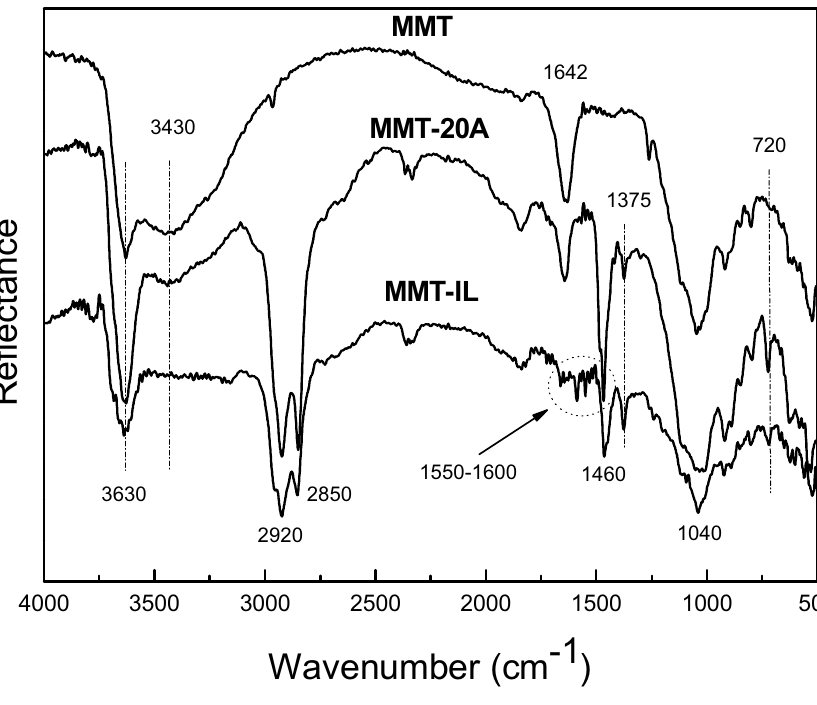
Fig. 4 Thermogravimetric curves and the first deriva- tive curves for the MMT-20A, MMT-IL and pristine MMT HT— hydrogenated tal- low with ~ 65% C18, ~ 30% C16, ~ 5%